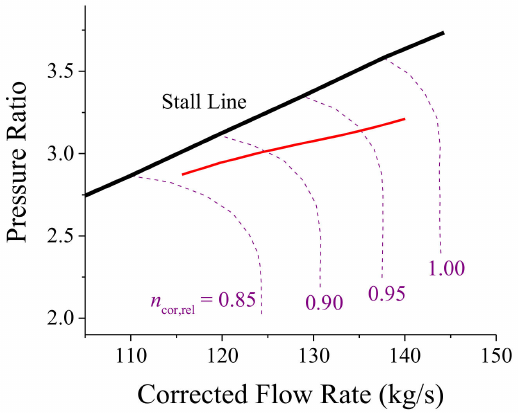
Figure 3. Matched Operating Line of Front Fan vs. Flight Mach